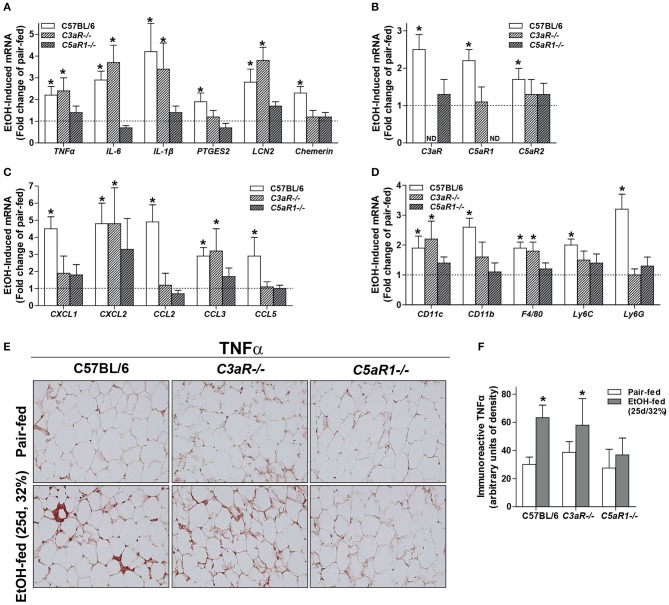
Chronic ethanol feeding increases the expression of inflammatory factors in WT and C3aR−/− mice. WT, C3aR−/−, and C5aR1−/− mice were allowed free access to ethanol (32%, d25) or pair-fed control diets. Expression of mRNA for (A) adipokines, cytokines, (B) complement receptors, (C) chemokines, and (D) leukocyte markers in gonadal adipose tissue. Values are expressed as the fold increase over genotype pair-fed controls. Values represent means ± SEM, values with *were significantly different from pair-fed controls within genotype (P<0.05), n = 4–8 pair-fed, n = 6–12 EtOH-fed mice. (E) Paraffin-embedded gonadal adipose tissue was stained for TNFα. Nuclei were counterstained with hematoxlin. All images were acquired using a 20 × objective. (F) TNFα-stained areas were quantified from at least three images per slide using Image-Pro Plus software. Values represent means ± SEM, values with * were significantly different from pair-fed controls within genotype (P<0.05). n = 3–7 pair-fed and 4–12 EtOH-fed mice.